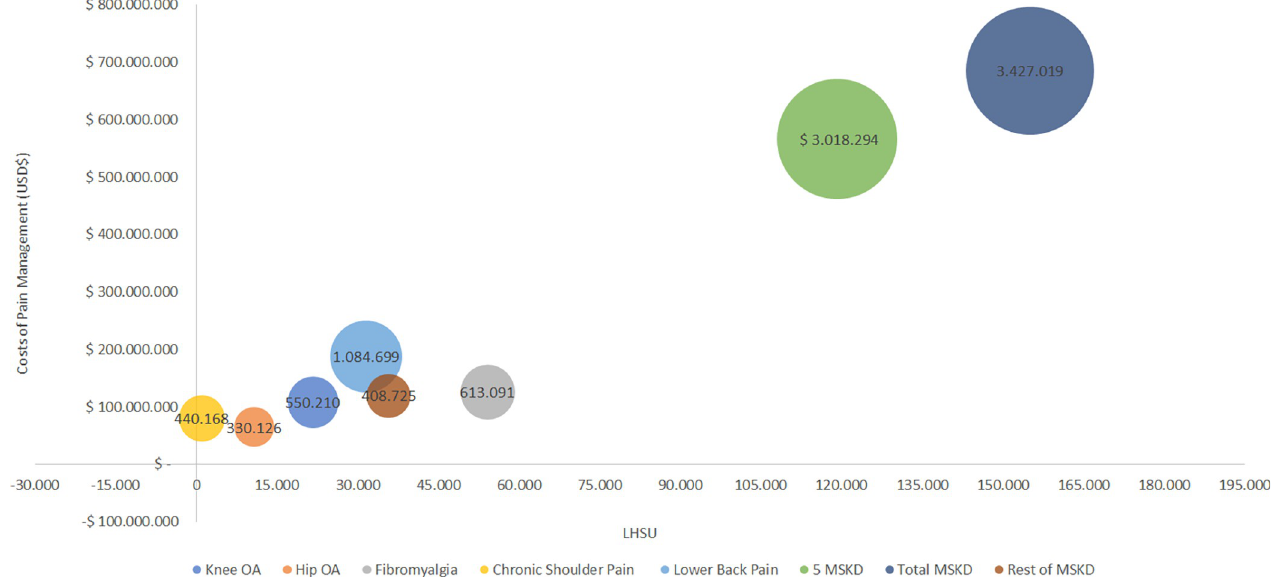
Fig 3. Cost and consequences plot of chronic pain. The figure represents the most significant costs (pain management) and consequences (LHSU) outcomes. The population of each health problem has been represented through the circle size.